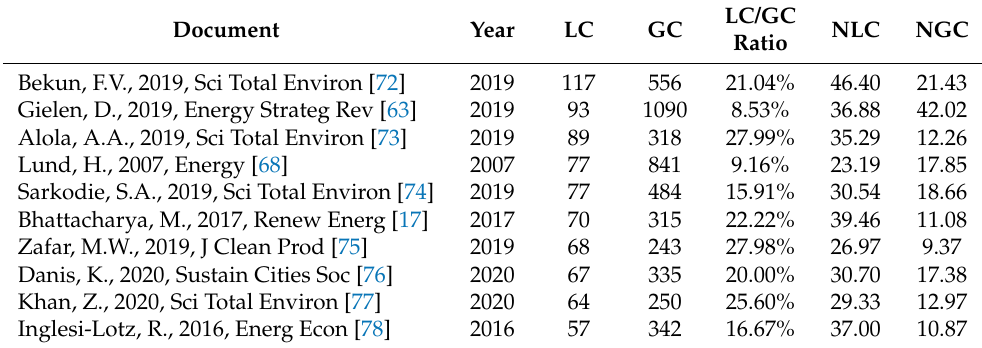
Table 6. Most local cited documents.